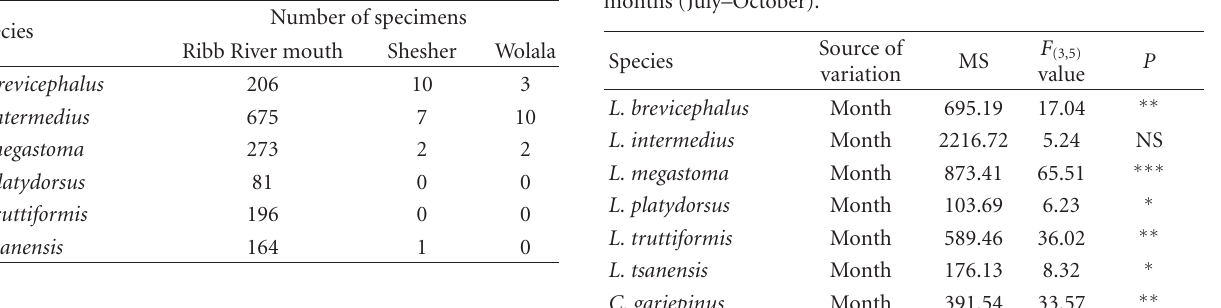
Table 5: One-way ANOVA result on the catch data of the six Labeobarbus species from Ribb River mouth and C. gariepinus from Shesher and Welala wetlands, for di ff erences in the four spawning months